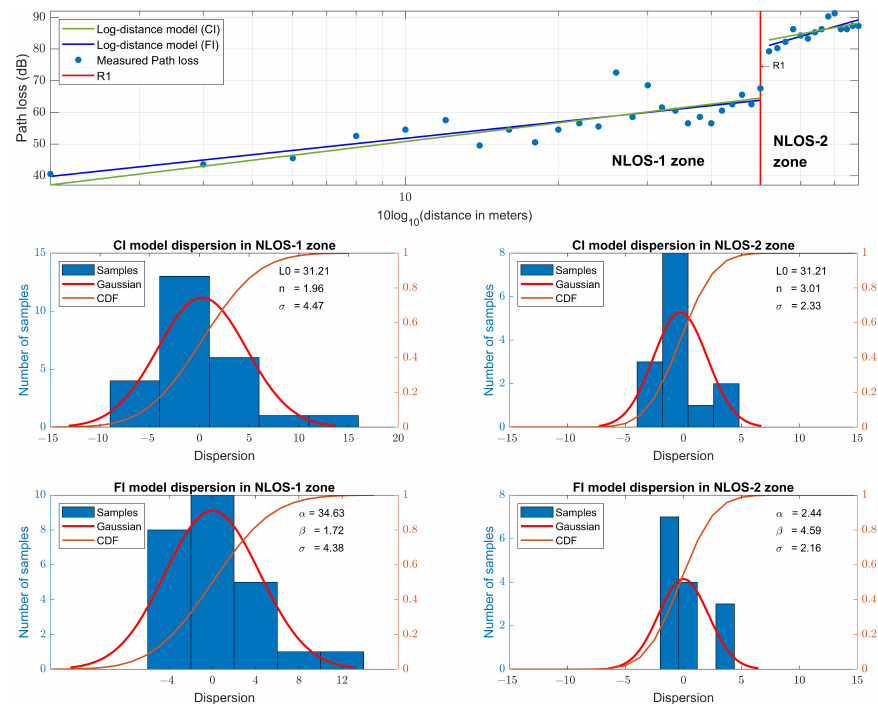
Figure 8. LoRa RSSI path loss models at 868 MHz and their dispersion.